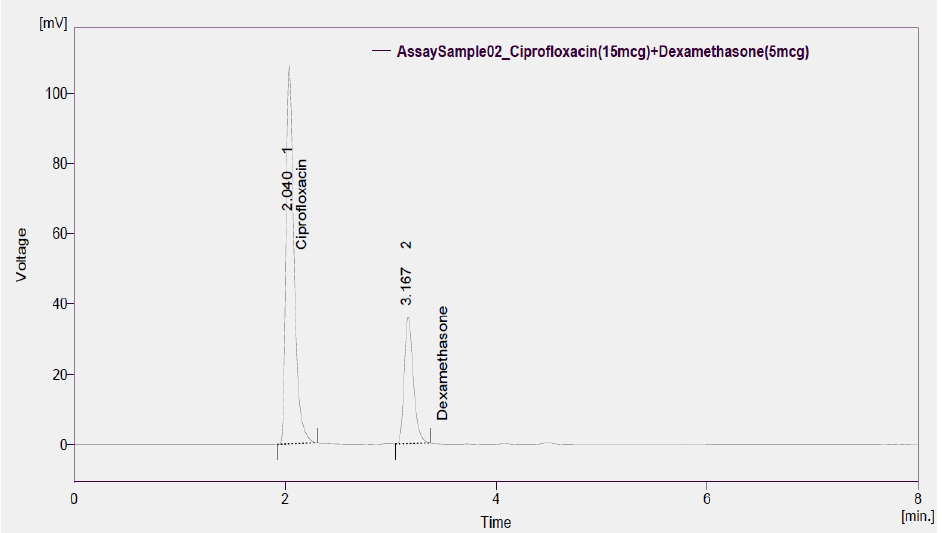
Figure 3: Typical chromatogram for the sample solution of CFH and DSP.